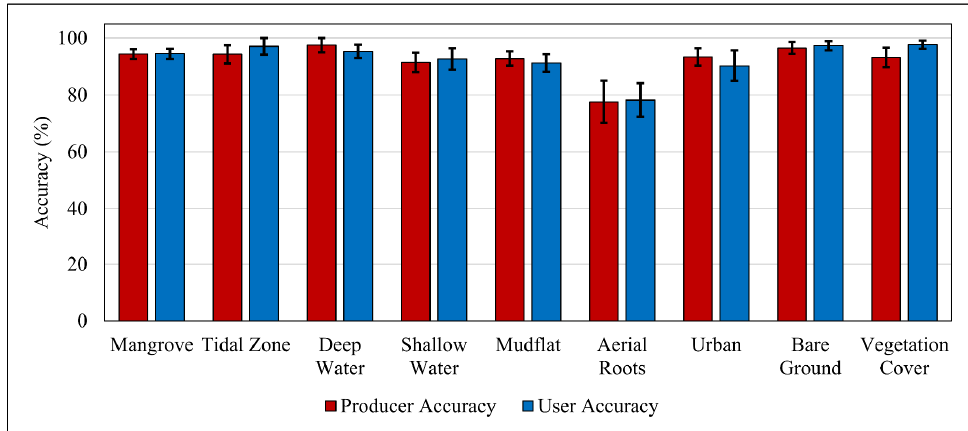
Figure 5. Average producer accuracy (PA) and user accuracy (UA) of different classes along with their standard deviation (black error bars) computed from ten iterations.